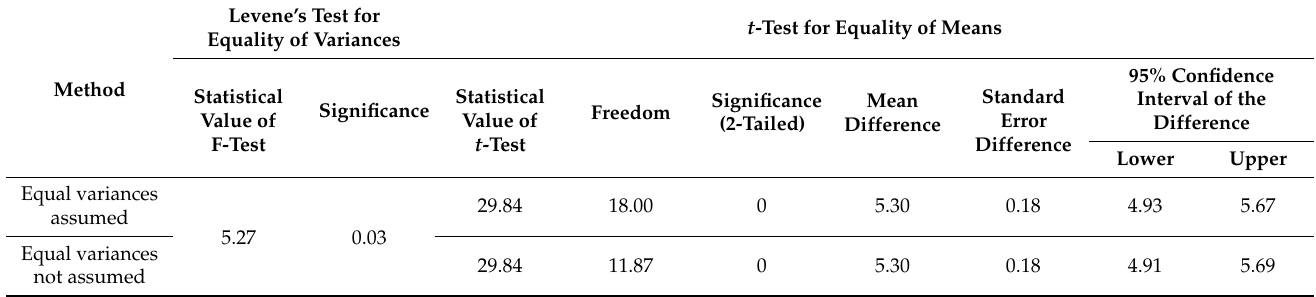
Table 10. t -Test result of color difference after cold liquid